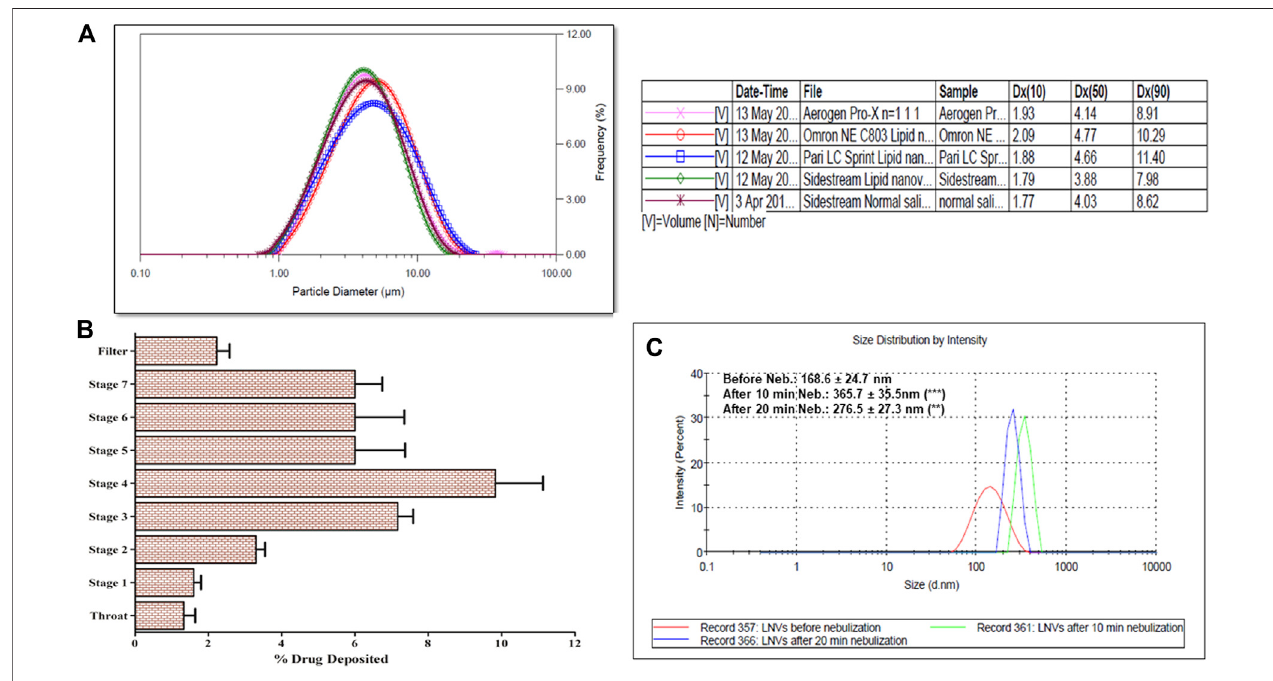
FIGURE 4 | (A) Microdroplet aerosol investigation of lipid nanovesicles (LNVs) employing Spraytec laser diffraction using jet and mesh nebulizers, with a lens of 300 mm focal length. Lowest Dx (50)value wasobserved with Sidestream nebulizer, which is signi fi cantly ( p < 0.05) different from Omron and Parinebulizers, while “ ns ” indicatesinsigni fi cantdifference( p > 0.05)fromAerogensolo; (B) Next-generationimpactorstudiesofLNVsemployingSidestreamnebulizerata fl owrateof15 Lmin − 1 , indicatingmaximumdepositiononStage3andStage4ofimpactor; (C) Stabilitypro fi leofLNVs,beforeandafternebulizationof20 min;Datarepresentmean ± SD values ( n (cid:2) 3). Data sets were compared between results, before and after nebulization (** p < 0.005, *** p <